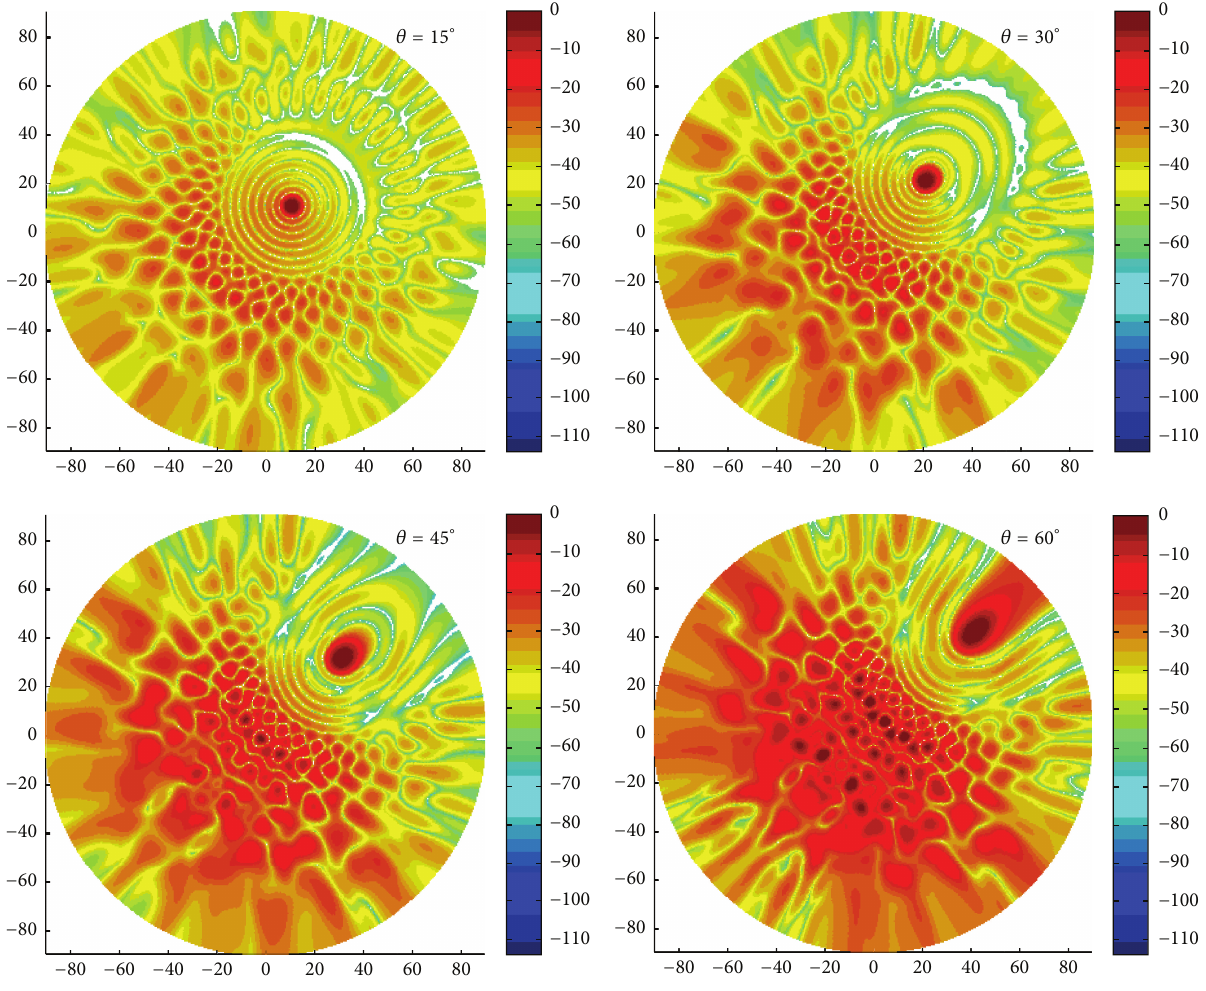
Figure 12: Scanning beam pattern of proposed sparse array.